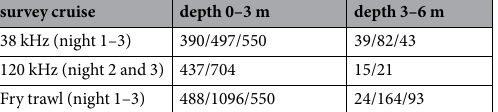
Table 1. Numbers of acoustically detected fish tracks and fish captured by the fry trawl. The results for individual nights are separated by /.